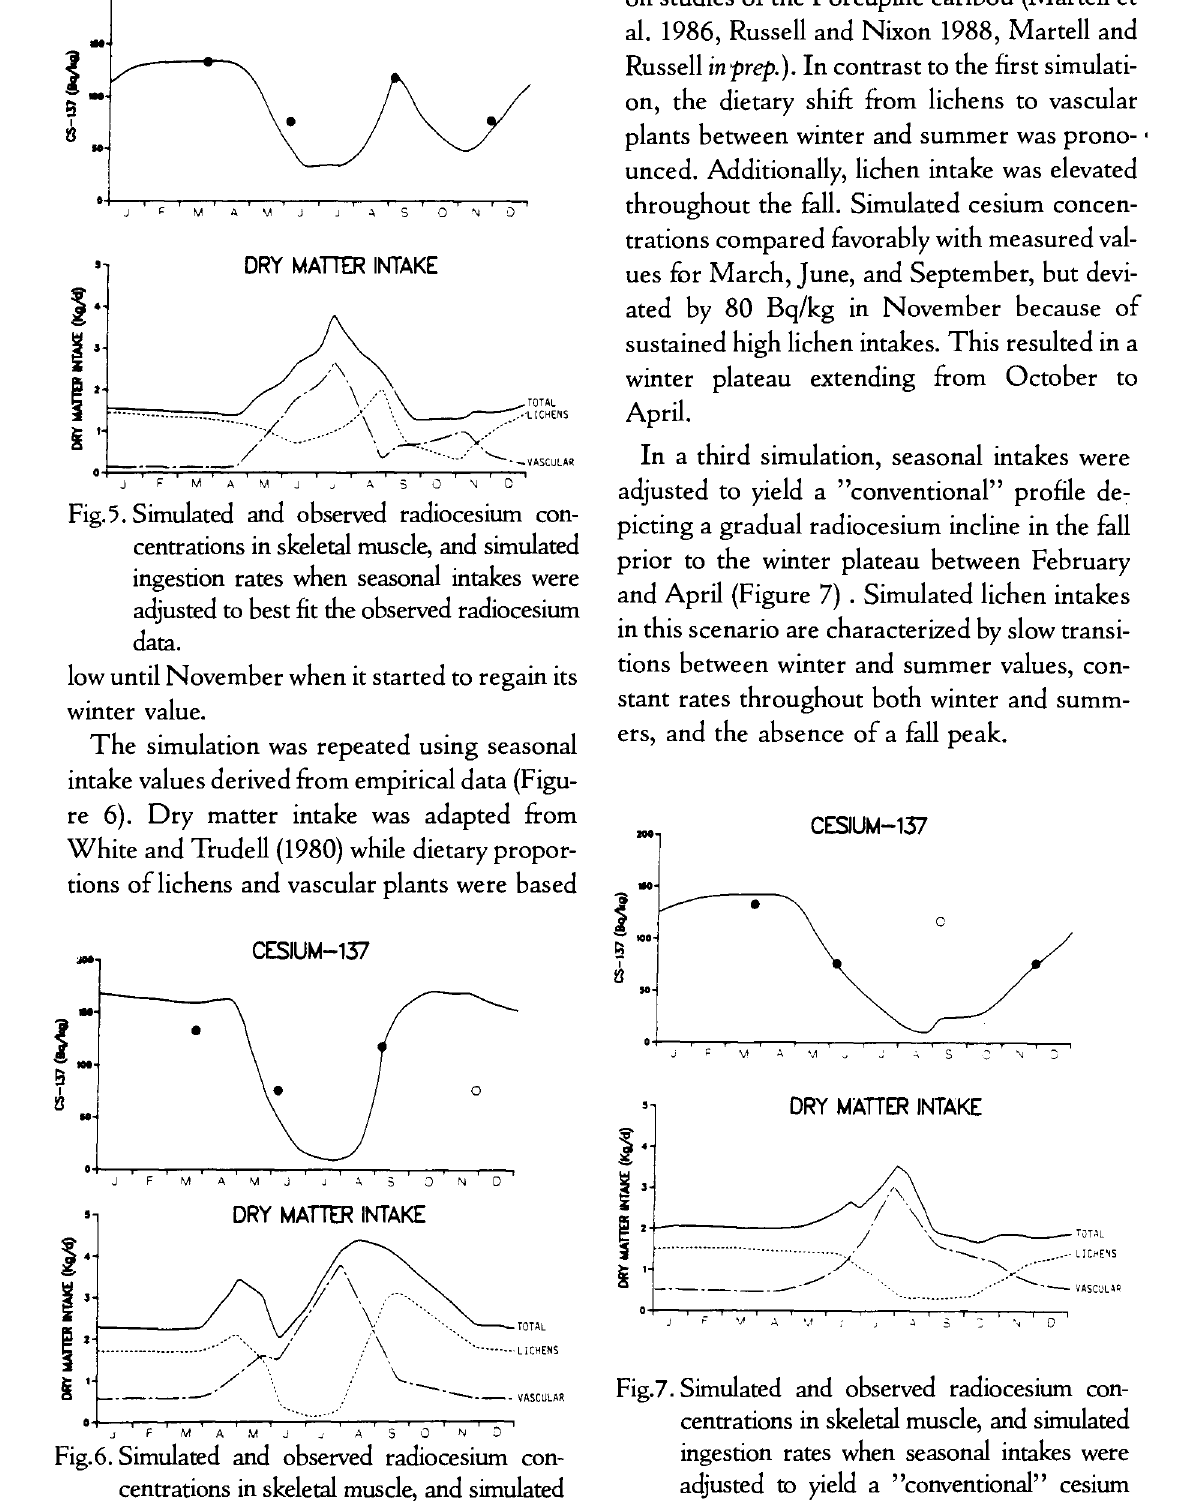
Fig. 6. Simulated and observed radiocesium con centrations in skeletal muscle, and simulated ingestion rates when seasonal intakes were based on empirical data.